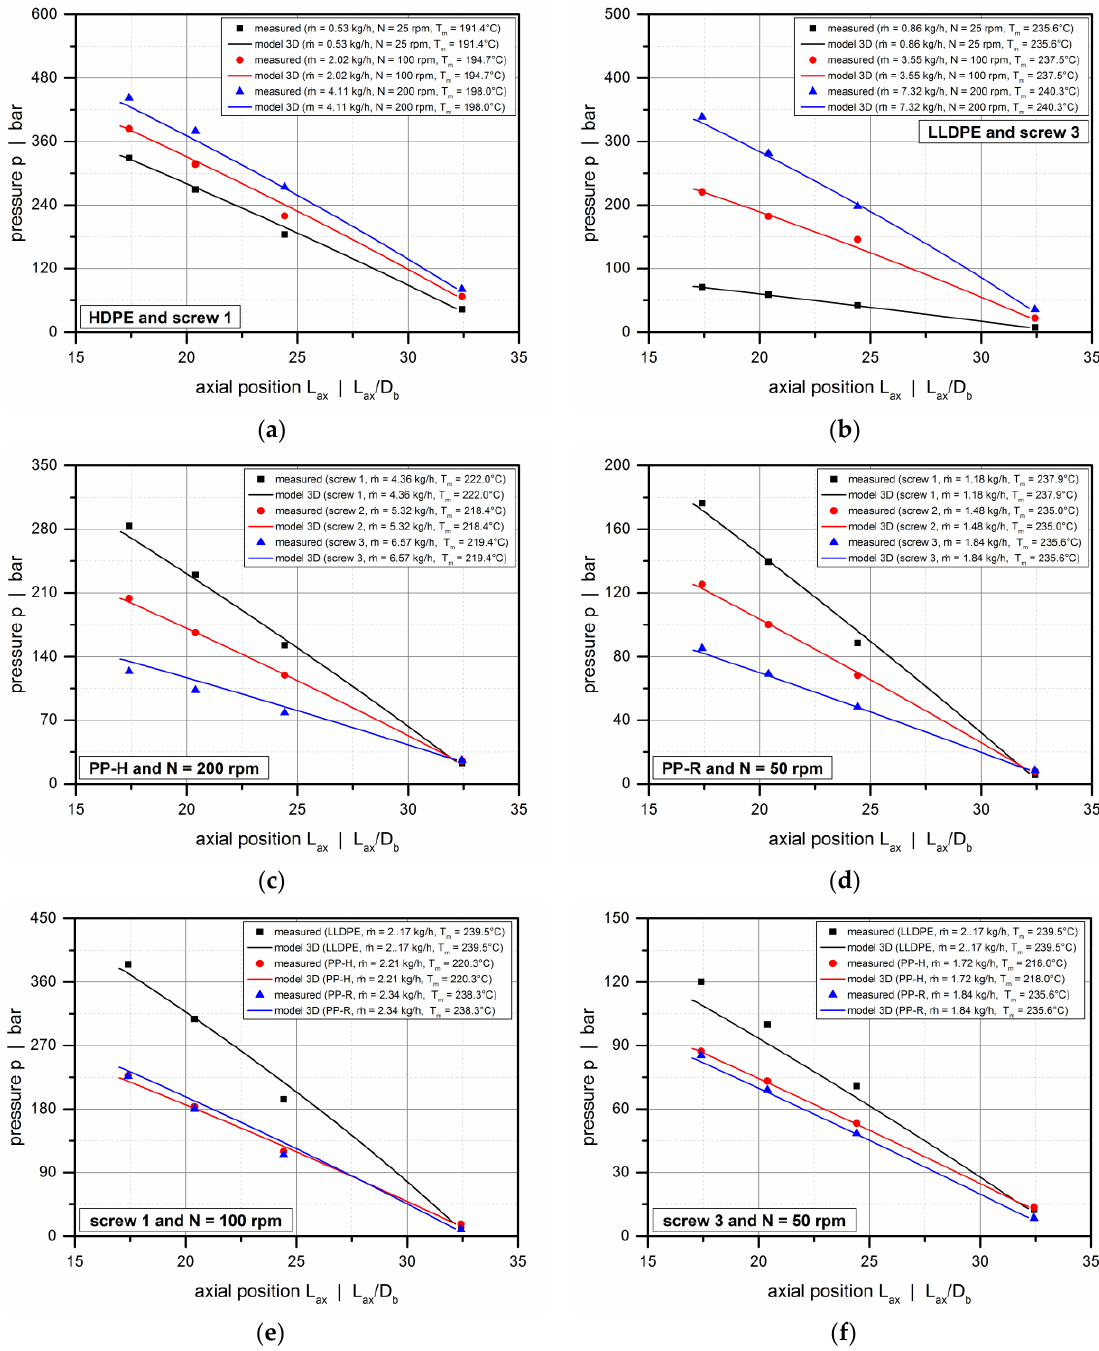
Figure 13. Comparison between experimental data and solutions resulting from model 3D. Axial pressure profiles for various experimental setups: HDPE, screw 1 ( a ); LLDPE, screw 3 ( b ); PP-H, N = 200 rpm ( c ); PP-R, N = 50 rpm ( d ); screw 1, N = 100 rpm ( e ); screw 3, N = 50 rpm ( f ).